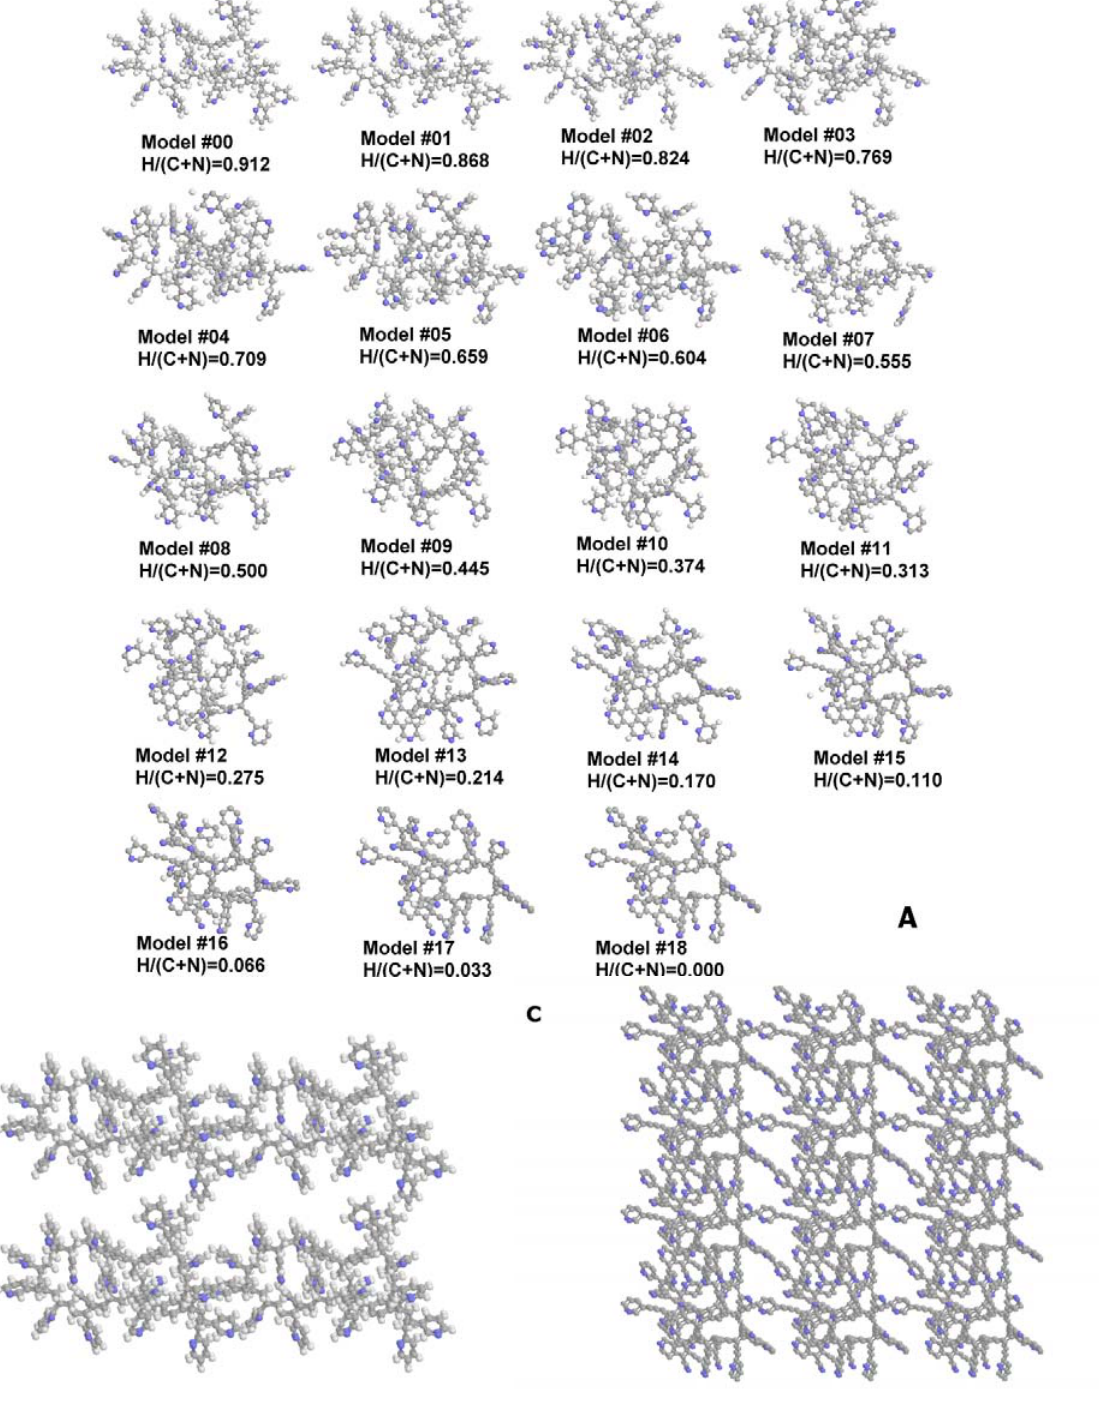
Figure 2. (a) Structures of studied periodic models basic units (point number) and H/(C + N) relationship. (b) starting periodic model (M#00) 2 × 2 × 2 supercell. (c) final periodic model (M#18) 2 × 3 × 4